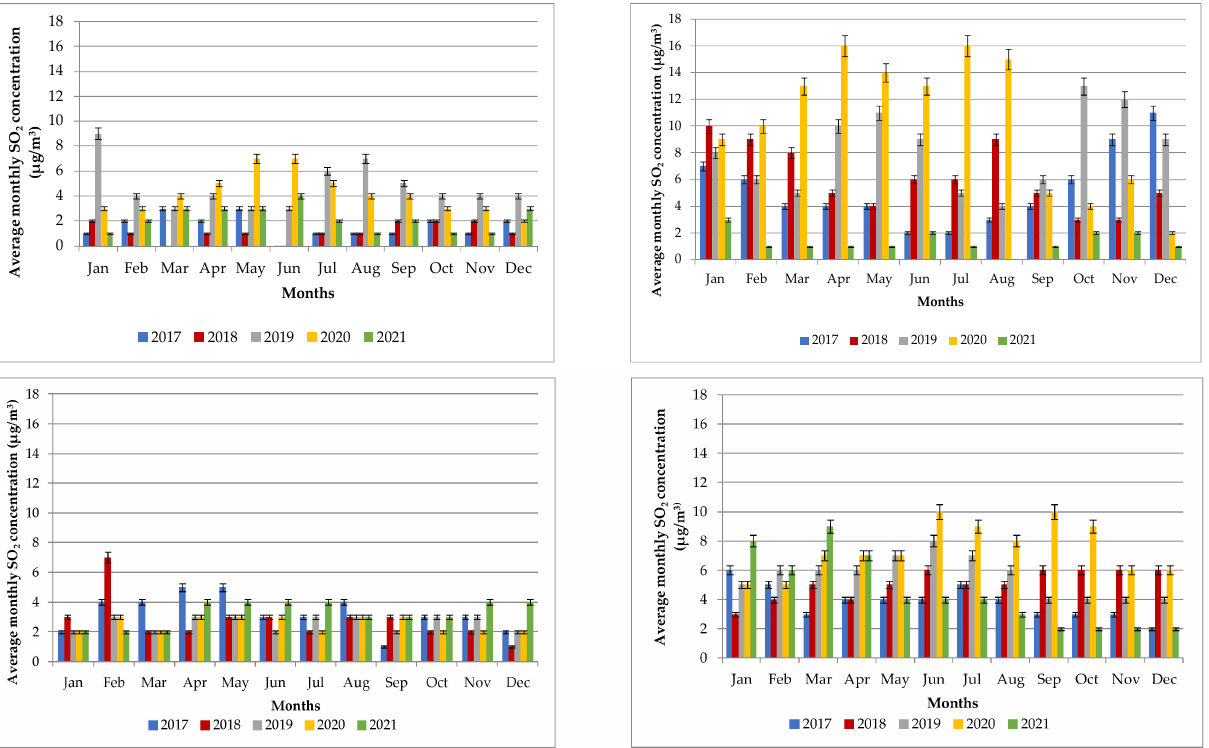
Figure 2. Average monthly SO 2 concentrations at locations A, B, D, and E between 2017 and 2021 (from left to right, from top to